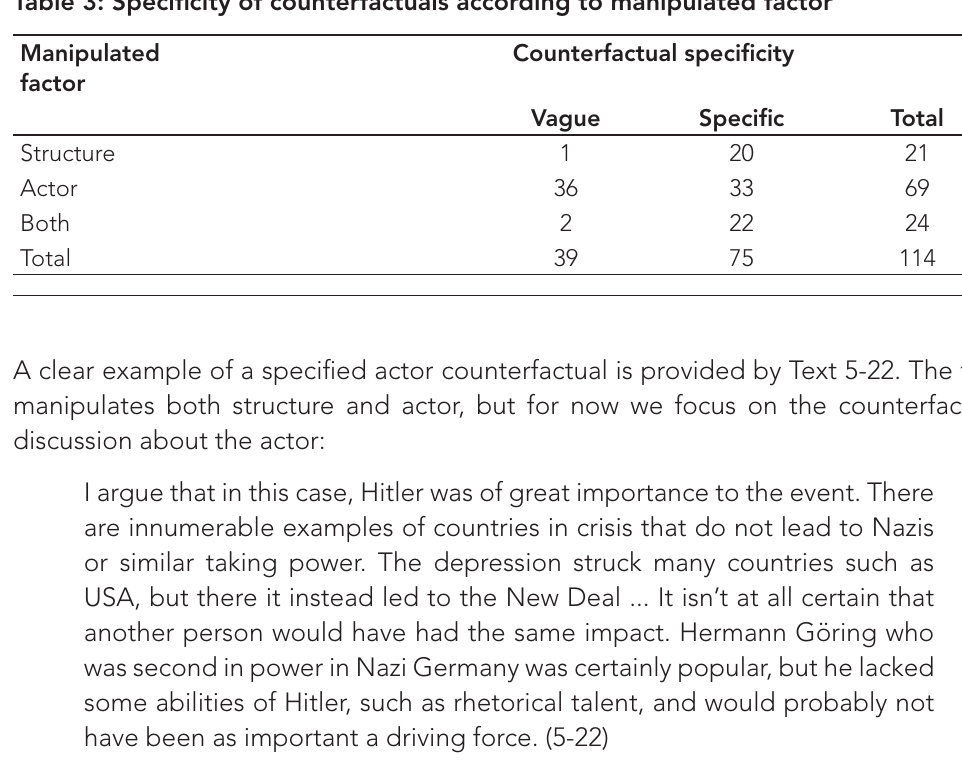
Counterfactual specificity Vague Specific